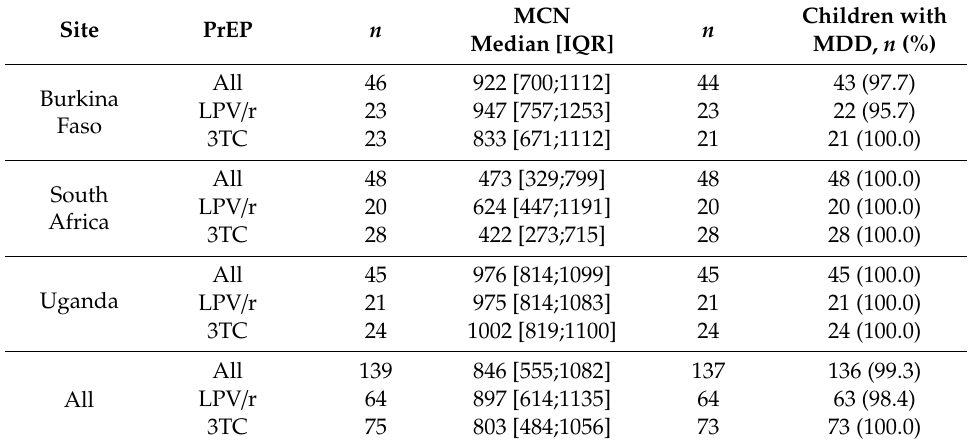
Table 3. mtDNA copy number per cell (MCN) and proportion of children with deleted mtDNA (MDD) at PrEP randomisation (D7) by study